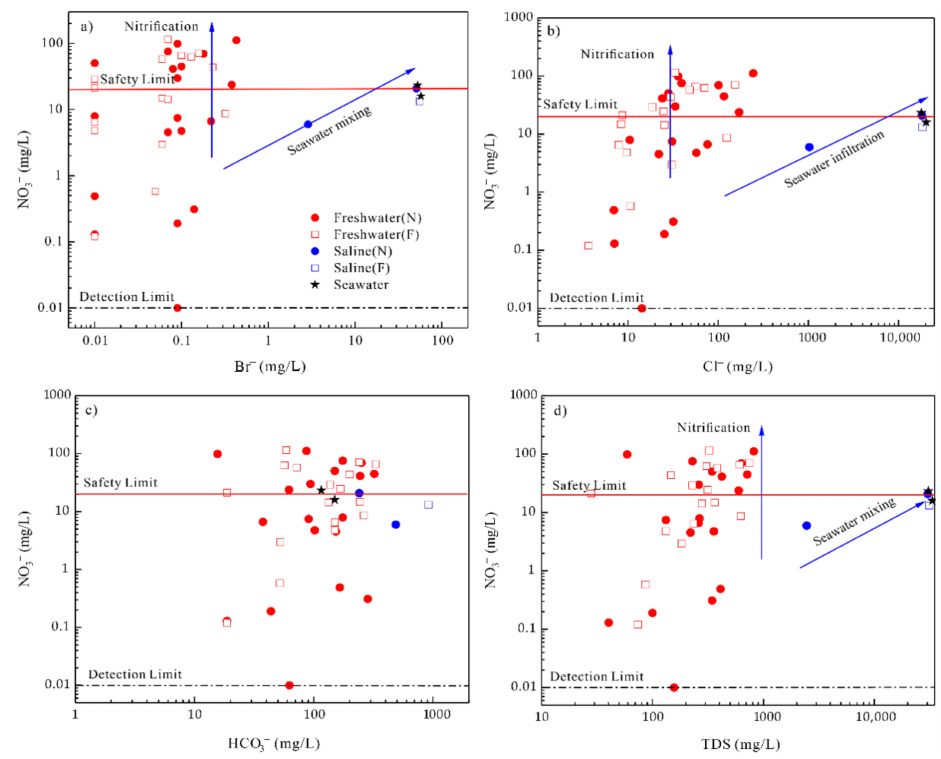
Figure 6. Plots of the source of NO 3 − among NO 3 − and HCO 3 − , Br − , Cl − , and TDS in groundwater. ( a ) NO 3 − versus Br − , ( b ) NO 3 − versus Cl − , ( c ) NO 3 − versus HCO 3 − , ( d ) NO 3 − versus TDS. The red lines represent the safety limit “y = 20”, which means points above this line have nitrate contamination. The black lines represent the detection limit “y = 0.01”, which means points below this line will not be detected for content of NO 3 − . The blue line represents the two trends, which are nitrification and seawater